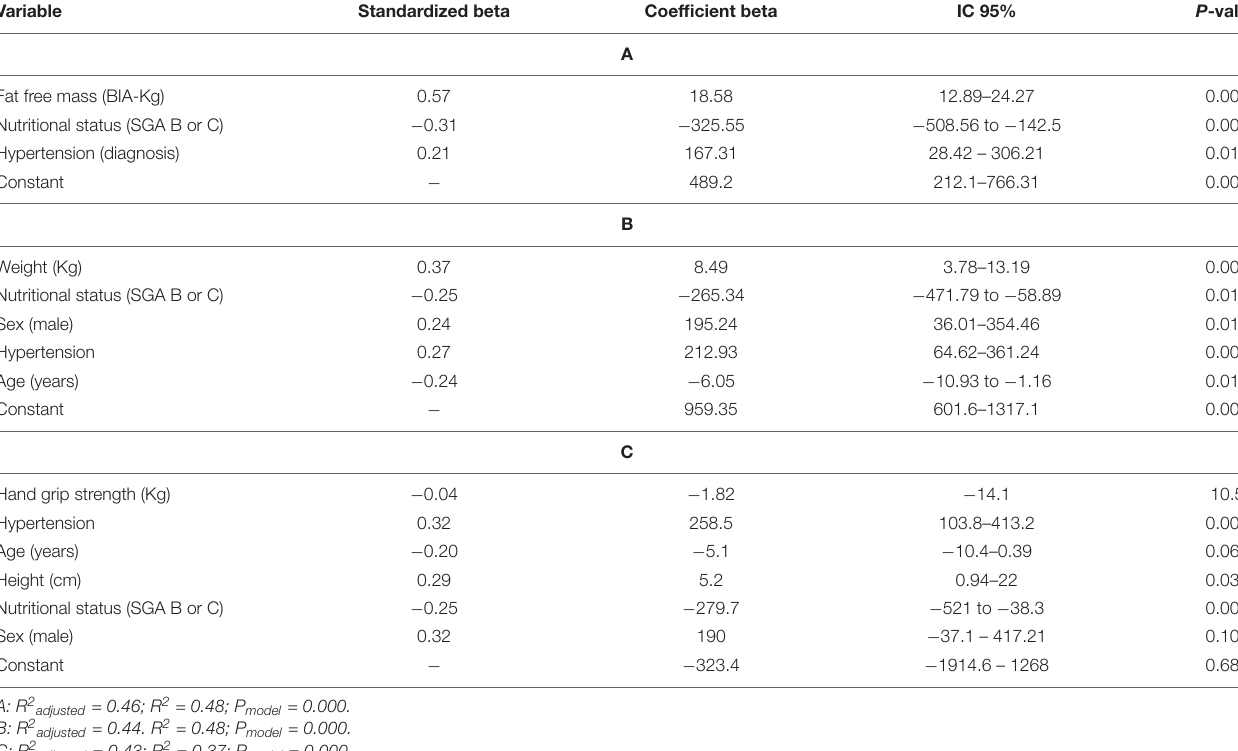
TABLE 2 | Linear regression for indirect calorimetry measurements (Fat-Free Mass) (Weight), and (Handgrip strength).